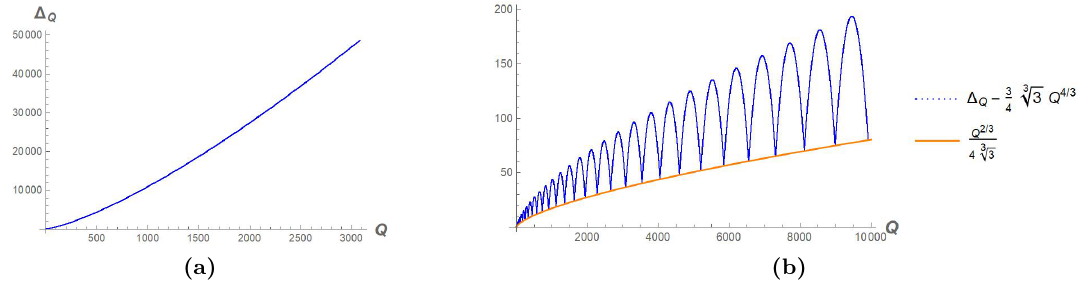
Figure 4. An illustration describing the behavior of the scaling dimension for a general value of Q in the d = 4 case. Figure 4a describes ∆ Q as a function of Q . In figure 4b, the blue dashed line corresponds to ∆ . The points 3 4 / 3 Q 4 / 3 as a function of Q , while the orange line describes Q 2 / 3 Q − 4 4 · 3 1 / 3 in which the blue dashed line meets the orange line correspond to cases in which Q is such that equation (6.10) is satisfied with integer values of n max